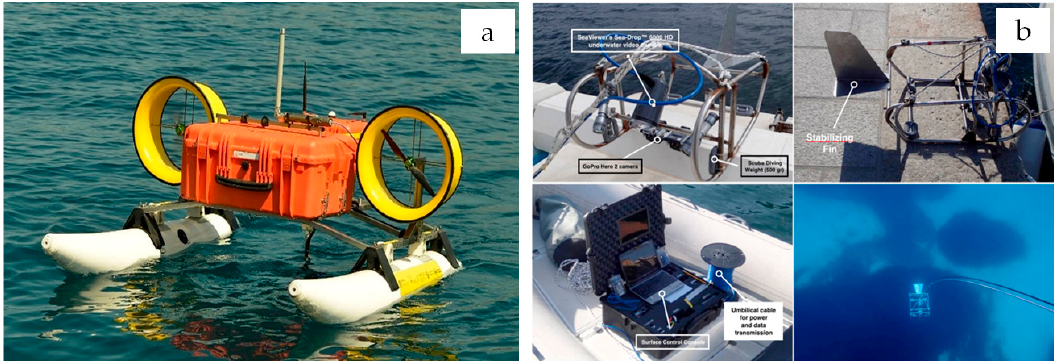
Figure 6. ( a ) Autonomous Surface Vehicle called DEvelopment Vehicle for Scientific Survey (DEVSS); ( b ) Underwater Towed Video Camera Systems (UTCS).